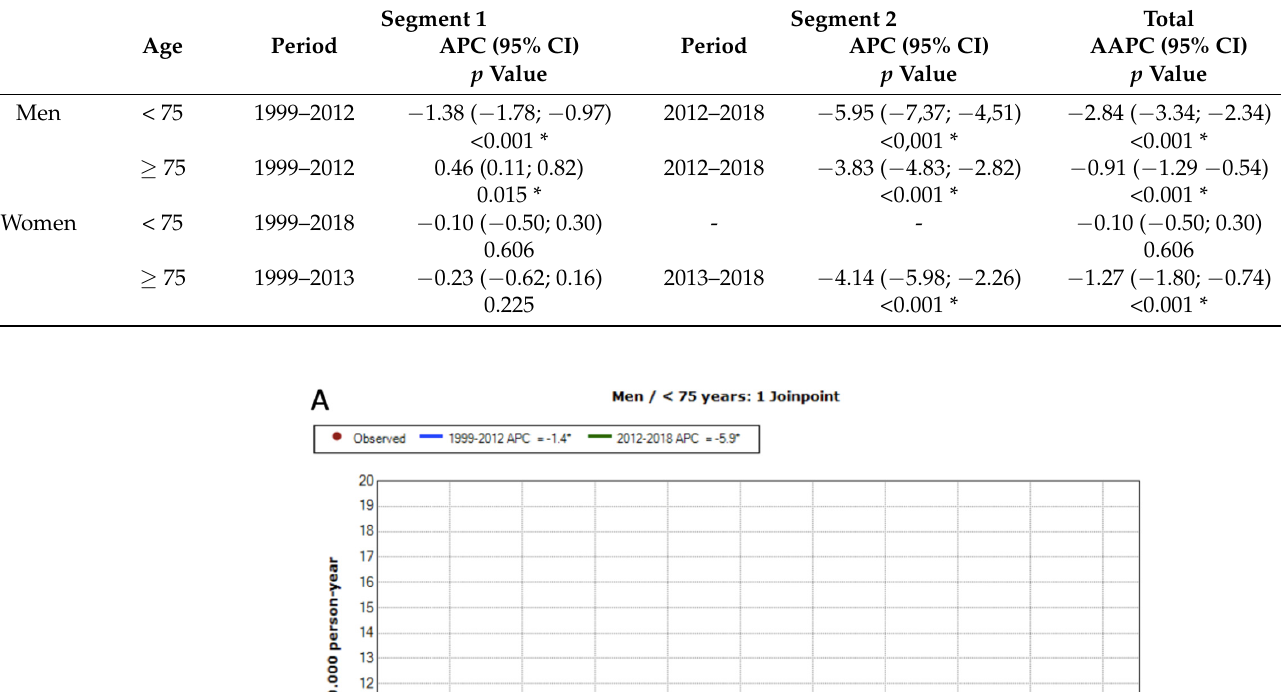
Table 3. Annual percentage change (APC) and average annual percentage change (AAPC) in mor- tality due to BC estimated by Joinpoint regression in Spain by gender during the period 1999–2018. * p < 0.05; APC: annual percentage change for the corresponding segment; AAPC: annual average percentage change for the entire period; 95% CI: 95% confidence interval.